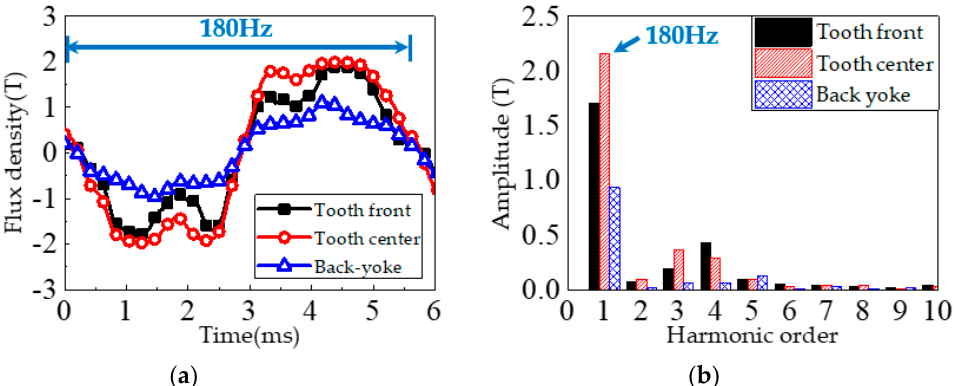
Figure 4. Variation of the radial magnetic flux densities with time at the front of tooth, center of tooth, and back yoke in the inner stator. ( a ) Waveform and ( b ) Time harmonic spectra.